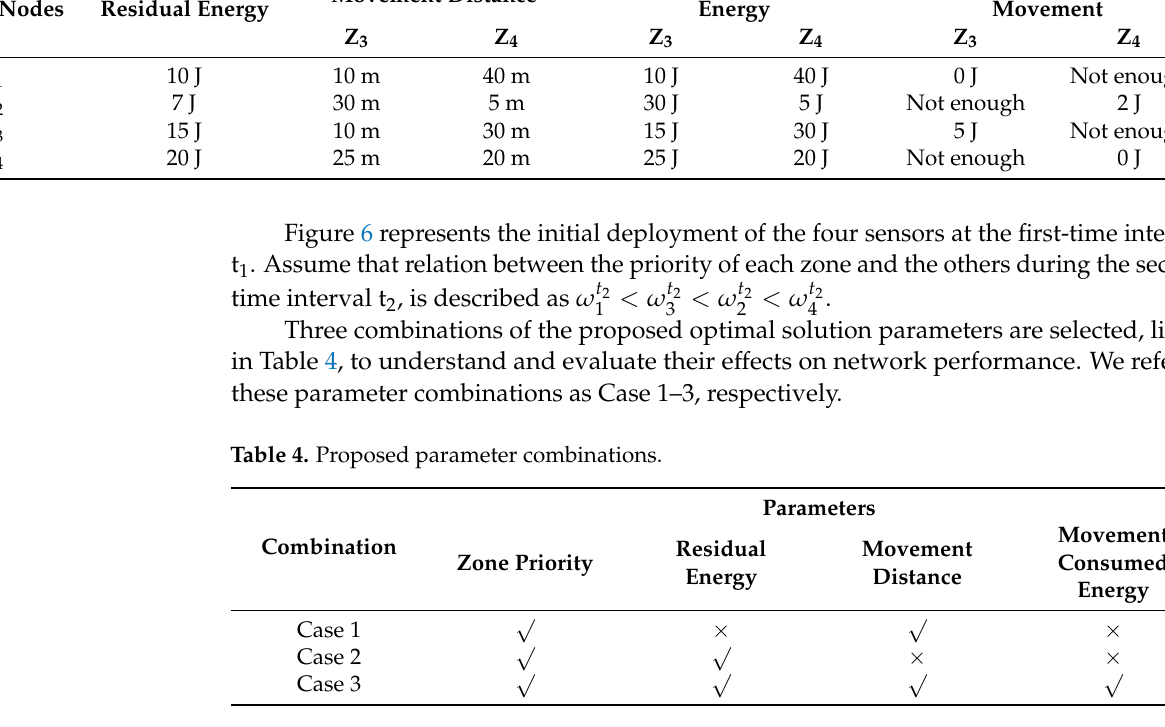
Table 4. Proposed parameter combinations.